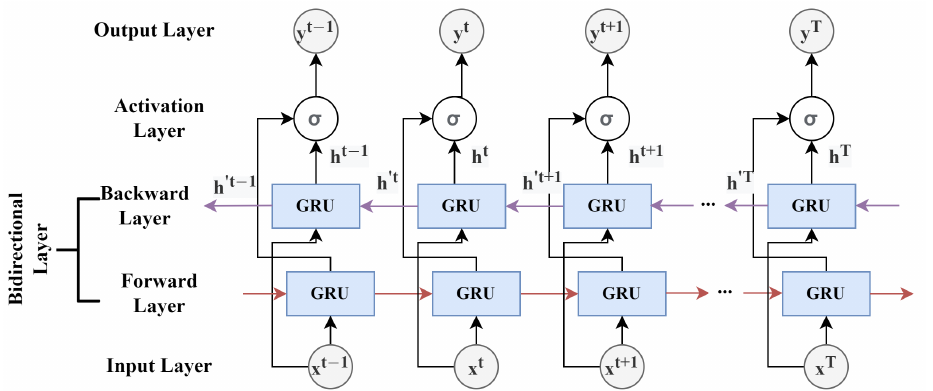
Figure 5. The structure of a bidirectional GRU